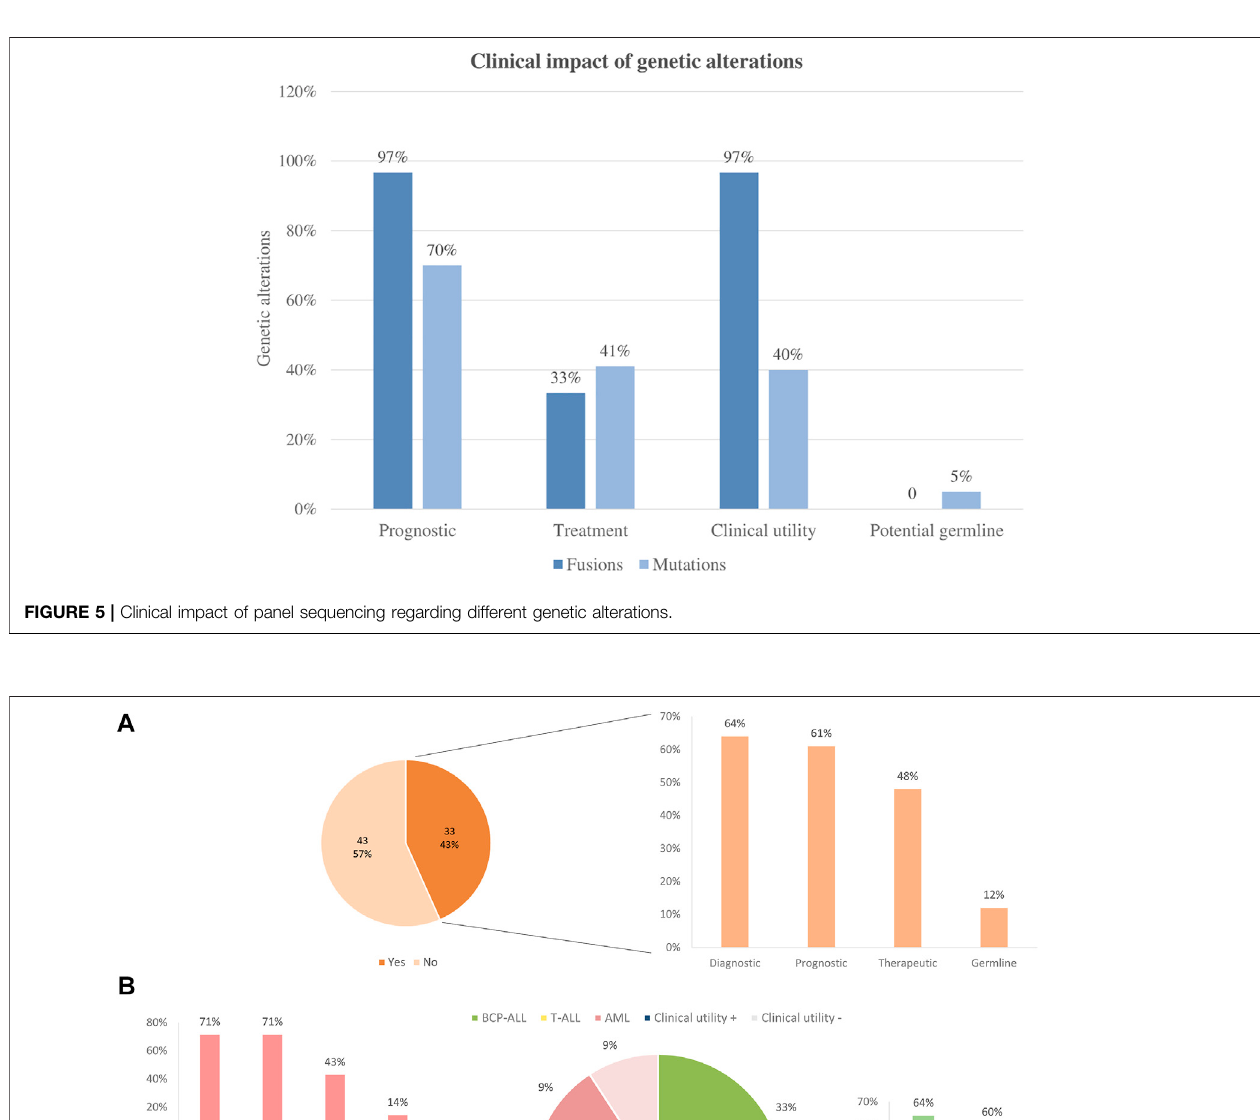
Frontiers in Molecular Biosciences |